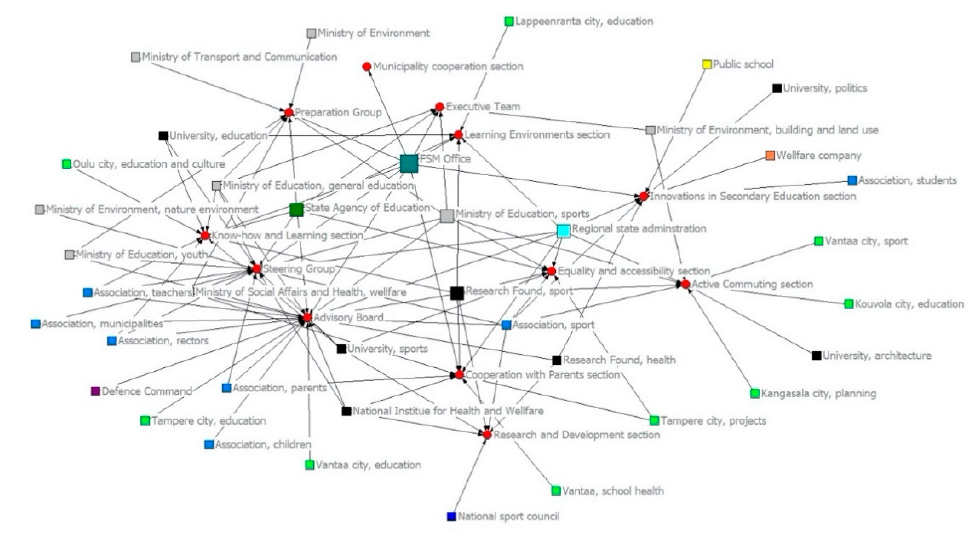
Figure 4. FSM program’s governance network in the second period